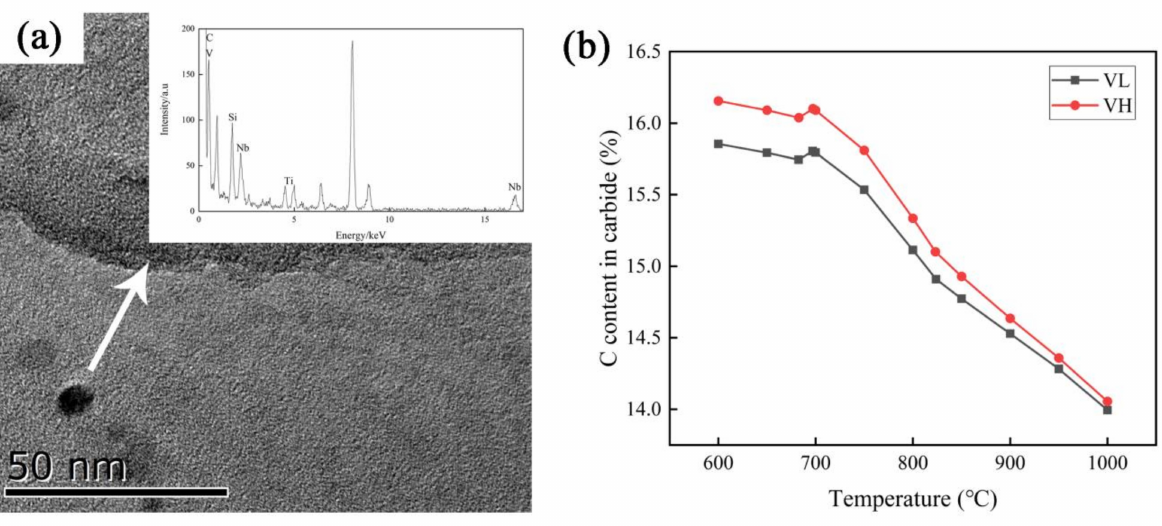
Figure 10. ( a ) TEM microstructure with the EDS result of 700-fractured sample of VH steel; ( b ) the curves of the carbon content in carbide versus temperature in two